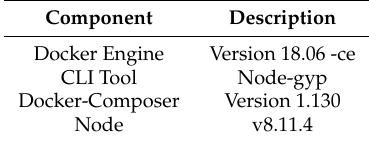
Table 5. Environmental Setup of Hyperledger Caliper.